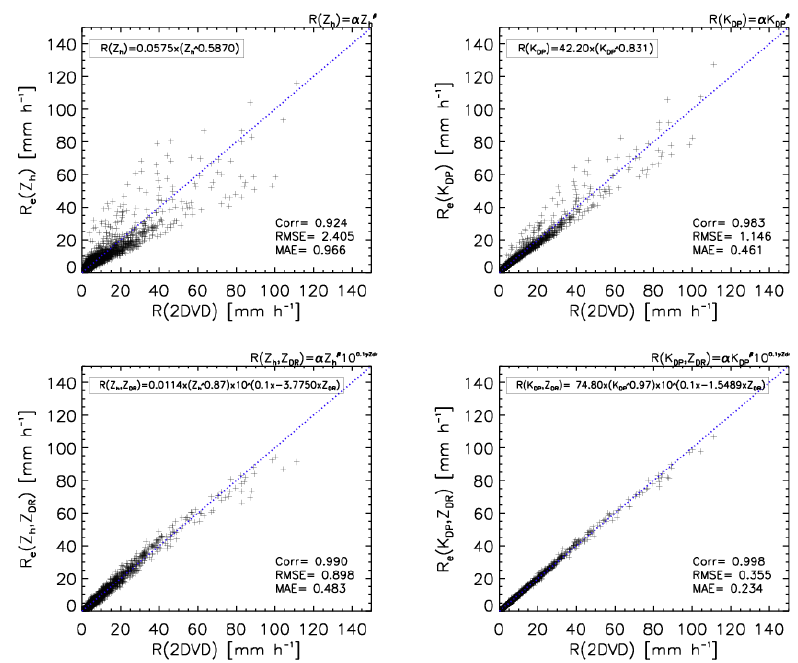
Figure 6. Scatterplot of R derived from observed DSDs (17618min samples) and R e estimated from combinations of polarimetric parame- ters. R e was then obtained from the same data